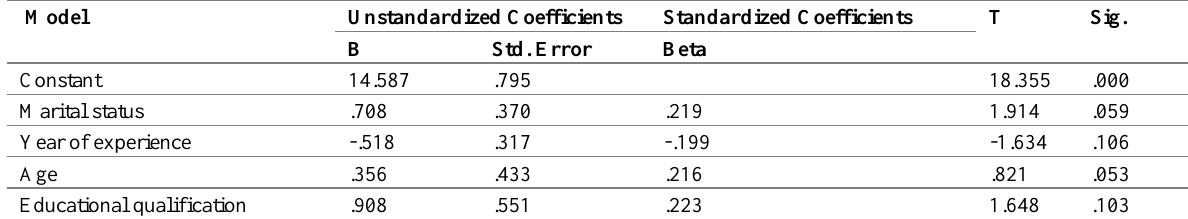
Table 4: Regression Analysis Showing Influence of Marital Status, Year of Experience, Age and Educational Qualifications of